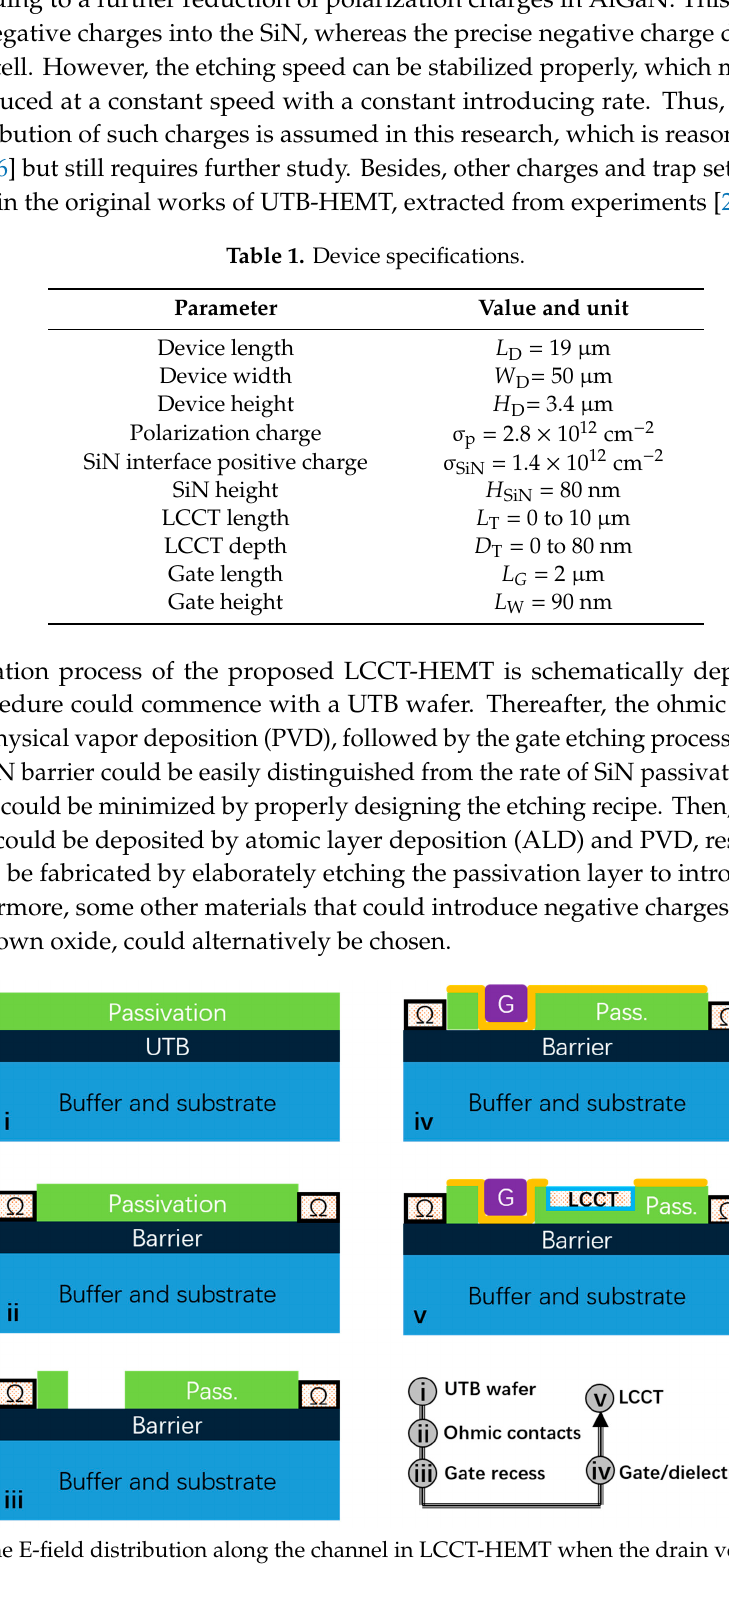
Figure 3. The schematic charges and electric field distribution of ( a ) conventional ultra-thin barrier HEMT (UTB-HEMT), ( b ) LCCT-HEMT with a short LCCT, and ( c ) LCCT-HEMT with a longer and deeper LCCT (red arrow represents electric field). As shown in Figure 1b, the recessed LCCT exerts two main effects. The first one is that, as mentioned above, the LCCT relieves the stress of the AlGaN layer, turning out a reduction of the polarization charges; whereas the other one, which has been depicted before as well, is that negative charges are introduced into the remaining SiN during the formation of the LCCT, which attracts the